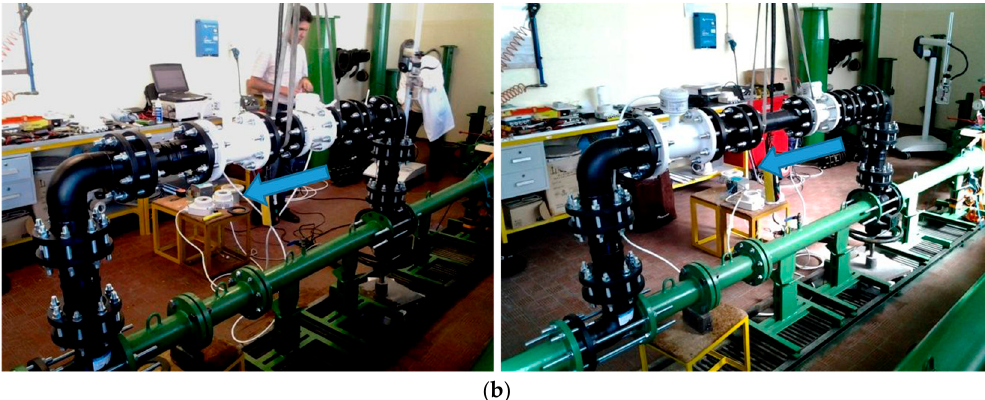
Figure 7. System layouts 1 and 2: ( a ) facility scheme; ( b ) lab installation, with flow direction identified by the blue arrow.